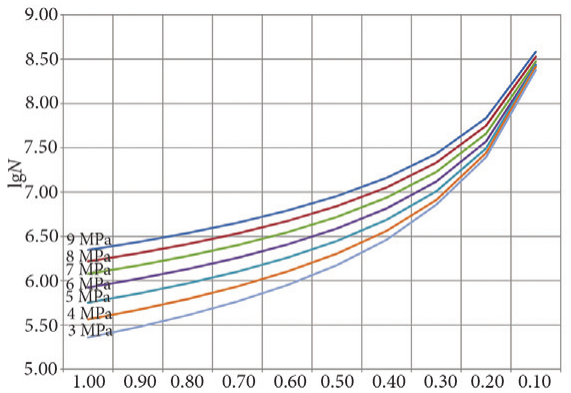
Fig. 5. Durability of asphalt concrete under cyclic continues deformations